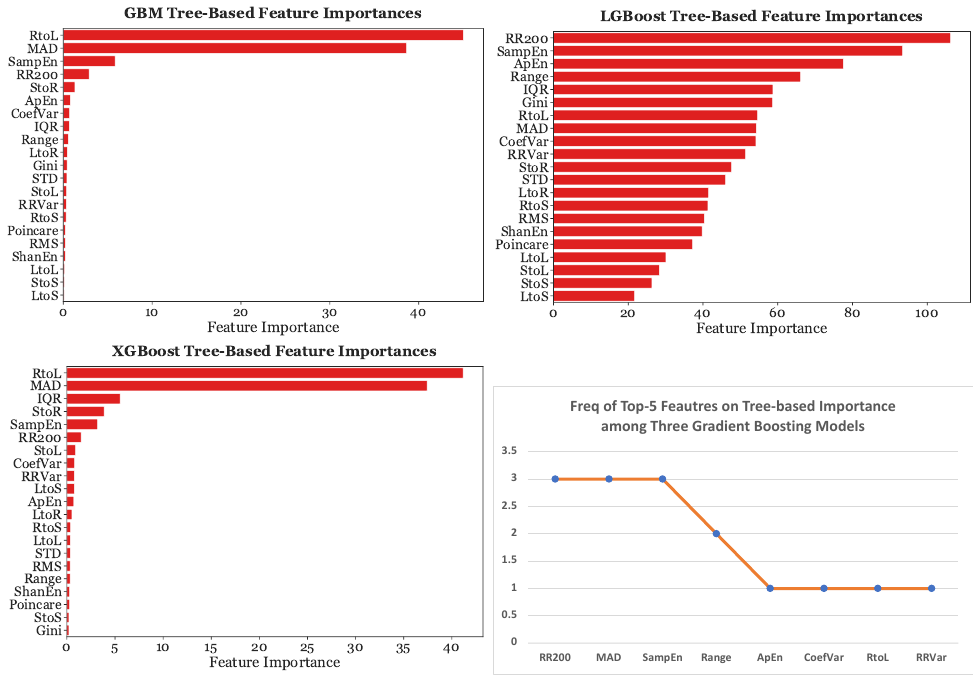
Figure 14. Tree-based importance for Gradient Boosting Models with the 25-s segmentation